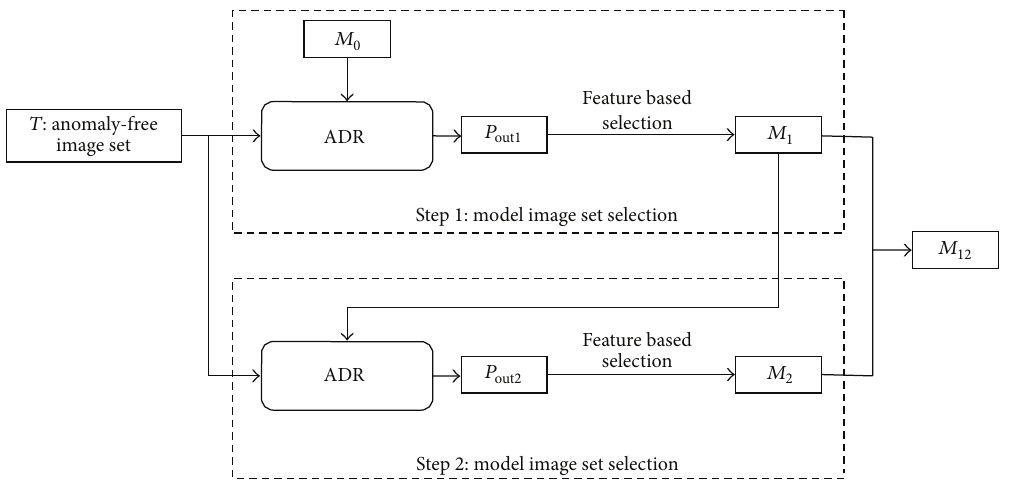
Figure 3: Schematic diagram of ADR Model